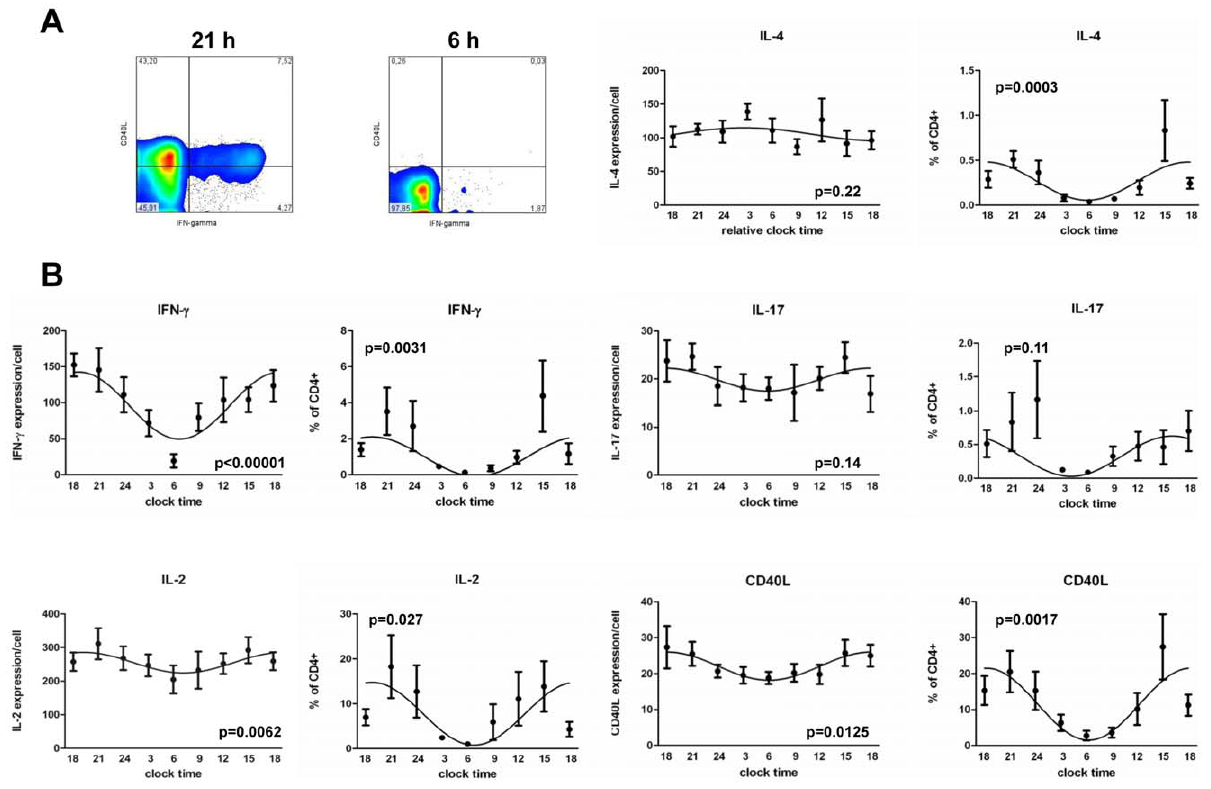
Figure 2. Circadian T cell activity ex vivo. Blood was sampled from seven healthy young males in three hour intervals starting at 6 PM over a 24 h period. CD4 + T cells were isolated from whole blood by MACS technology and the purified CD4 + T cells (mean purity: 94.99% 6 0.5%) were stimulated six hours with PMA/ionomycin. Cells were then fixed and CD40L, IL-2, IL-4, IL-17, and IFN- c expression was analyzed by FACS. A) Shows two FACS plots of one donor at the peak and trough of IFN- c production (time points as indicated). B) The graphs depict the GeoMean data (expression/cell), the percent of CD40L + cytokine + CD4 + T cells and the percent of CD40L + CD4 + T cells as indicated. The p-values depicted in each graph were calculated by Cosinor analysis (Table.